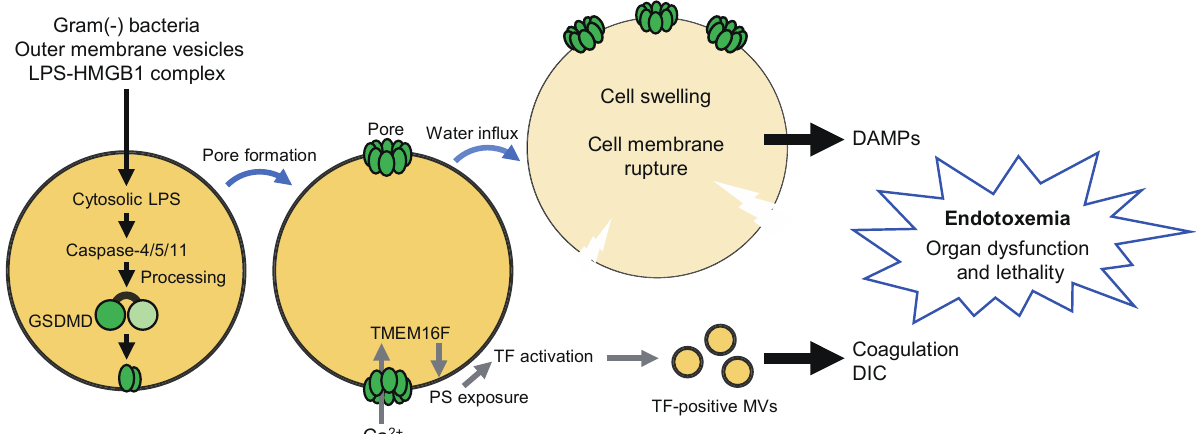
Figure 4. Pyroptosis contributes to the pathology of endotoxemia. Infection with Gram-negative bacteria may result in the release of lipopolysaccharide (LPS) into the cytoplasm of host cells. Outer membrane vesicles and HMGB1 can also deliver LPS into the cytoplasm. Cytoplasmic LPS then activates caspase-11/4/5, leading to proteolytic activation of GSDMD and consequent pyroptosis. DAMPs released from pyroptotic cells are thought to contribute to the pathology of endotoxemia. In addition, Ca 2+ influx via GSDMD pores triggers the activation of tissue factor (TF) through TMEM16F- mediated phosphatidylserine (PS) exposure. Tissue factor-containing microvesicles (MVs) induce coagulation and play a critical role in the development of disseminated intravascular coagulation (DIC), which is associated with increased mortality in septic